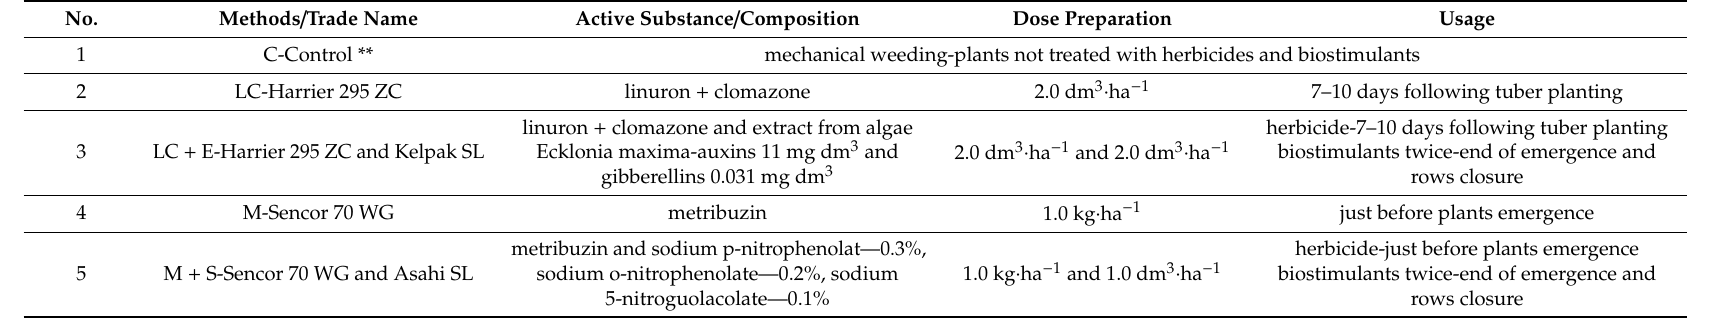
Table 2. Description of herbicides and herbicide with biostimulants used in the experiment—factor II [28,29].